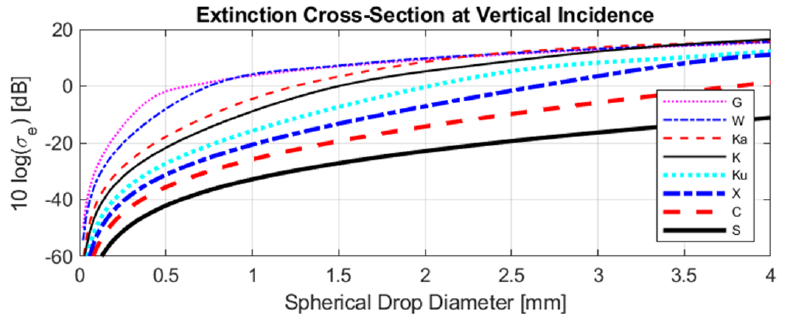
(cid:104) (cid:1)(cid:105) (cid:0) D eq σ λ b